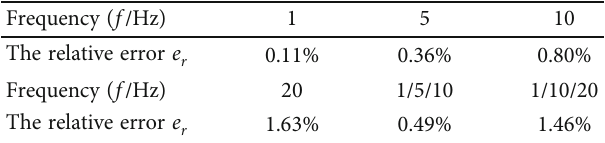
Table 5: The relative error of the adaptive compound